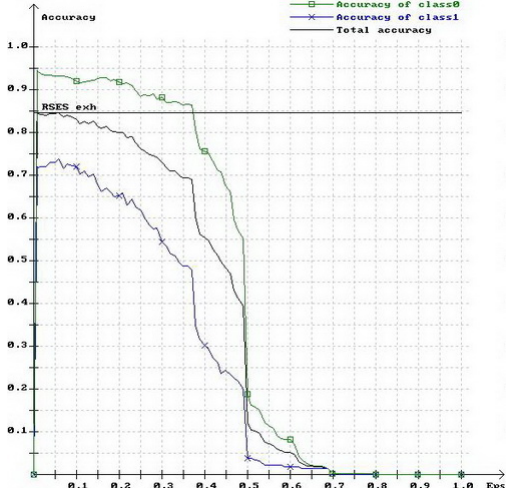
Fig. 5. Results for algorithm 6 v1, Best result for ε = 0 . 06: accuracy = 0.847826, coverage =